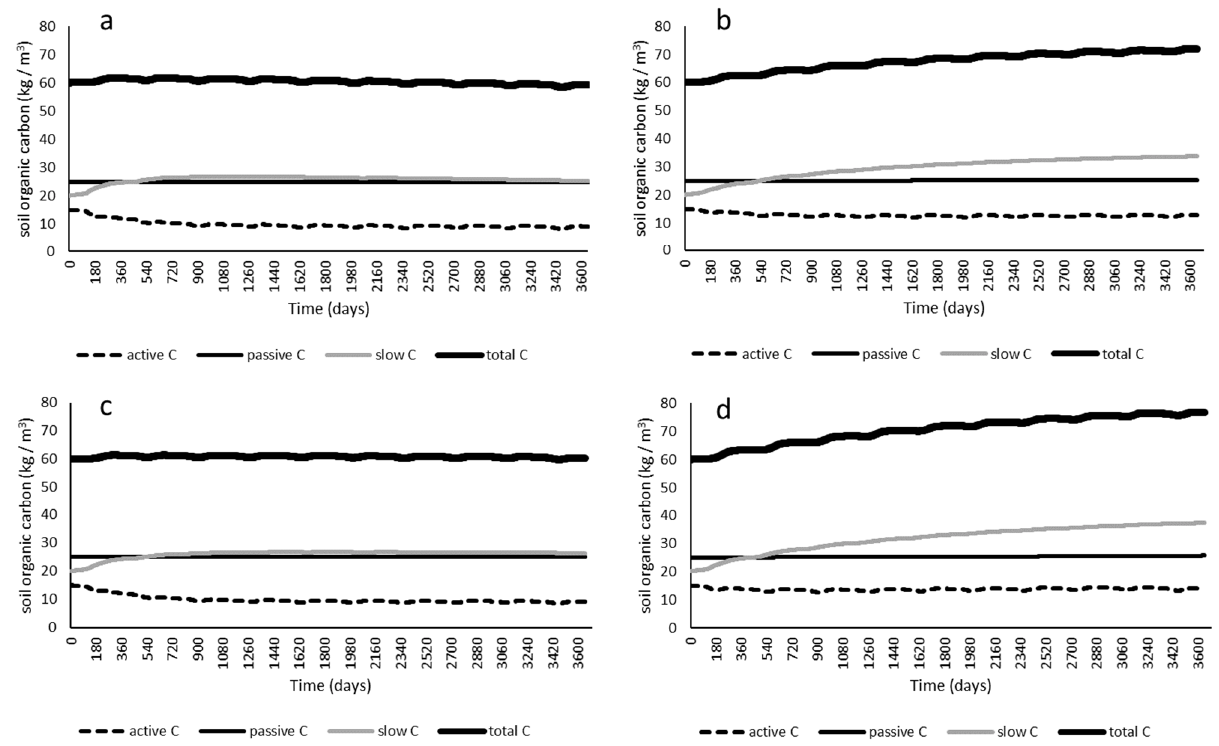
Figure 12. Partitioning of soil C into active, slow, and passive stocks, under the flood irrigation base case (panel a ), drip irrigation treatment (panel b ), conventional tillage base case (panel c ), and no-tillage treatment (panel d ).